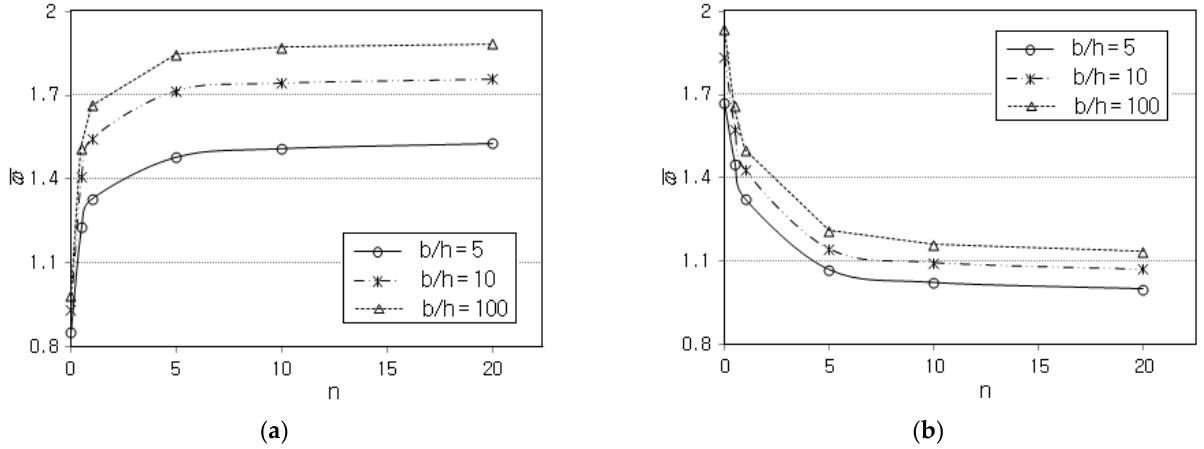
Figure 8. The gradient limits of calibrated fundamental frequency, ω , to the volume fraction index, n for: ( a ) softcore cases, ( b ) hardcore cases.